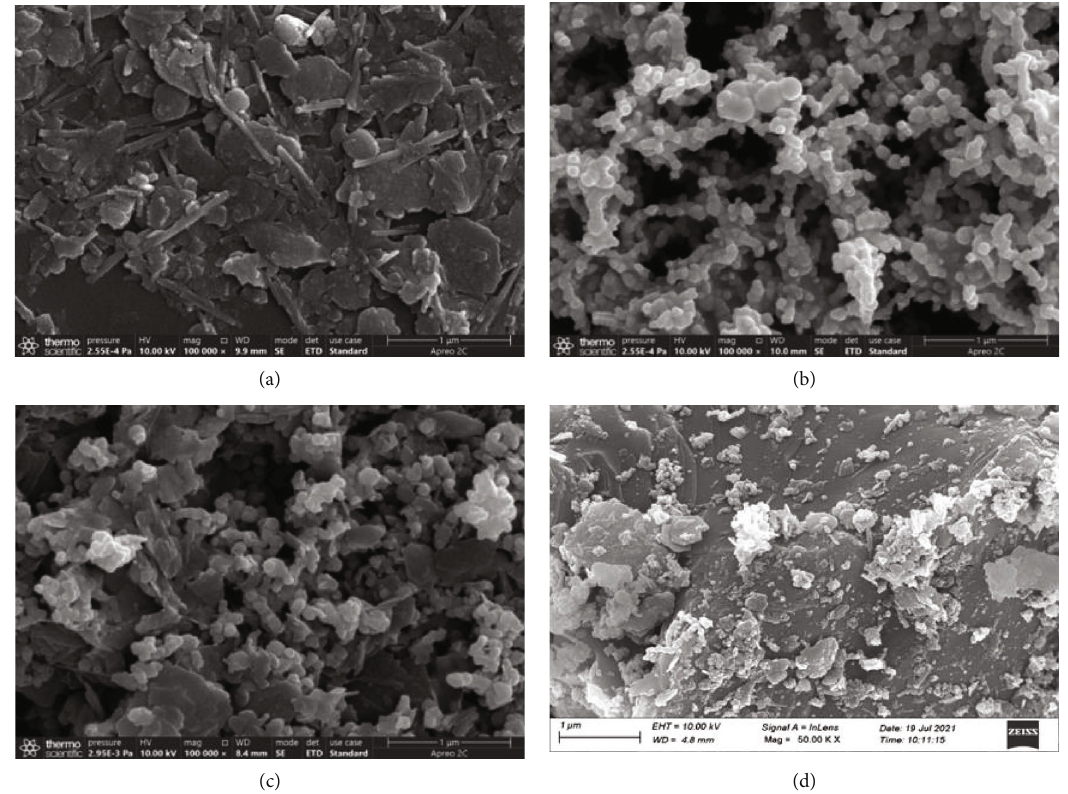
Figure 1: SEM images of (a) ATP, (b) nZVI, (c) ATP-nZVI, and (d) nitrate-laden ATP-nZVI. ATP: attapulgite; ATP-nZVI: nano-zero- valent iron-coated attapulgite; nZVI: nano-zero-valent